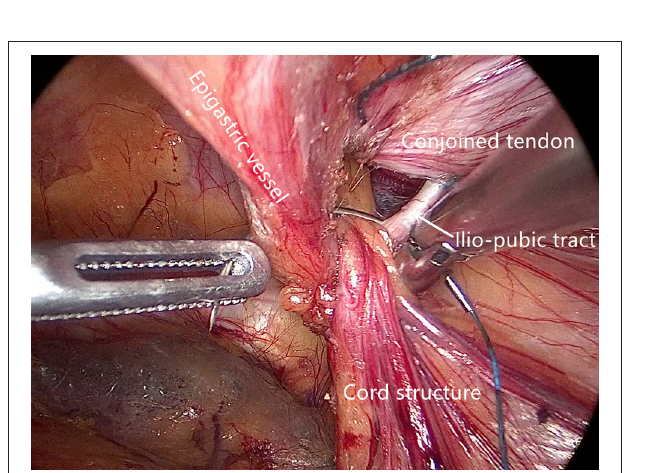
FIGURE 4 | The fourth stitch.